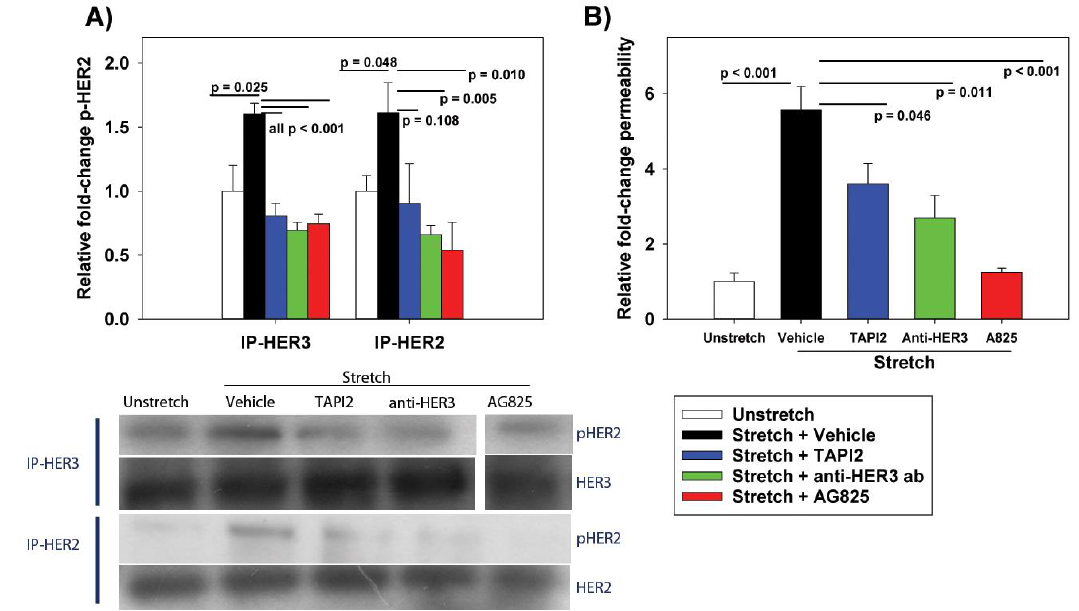
Figure 2. Effect of cyclic stretch (ΔSA 37%, 0.25 Hz, 10 min) and HER pathway inhibition on ( A ) human epidermal growth factor receptor-2 (HER2) activation and ( B ) permeability. ( A ) HER2 activation was measured by Western blot analysis of pHER2 after IP by (separately) anti-HER3 or anti-HER2 antibody. ( B ) Permeability was measured by BODIPY-ouabain fluorescence. Treatment with the NRG1-cleavage inhibitor TAPI2 (50 µM), anti-HER3 antibody (10 µg/mL), and HER2 phosphorylation AG825 (50 µM) mitigated stretch-induced increases in pHER2 and permeability. Values are normalized to unstretched cells. n = 5; p values represent the result of ANOVA and post- hoc Tukey.